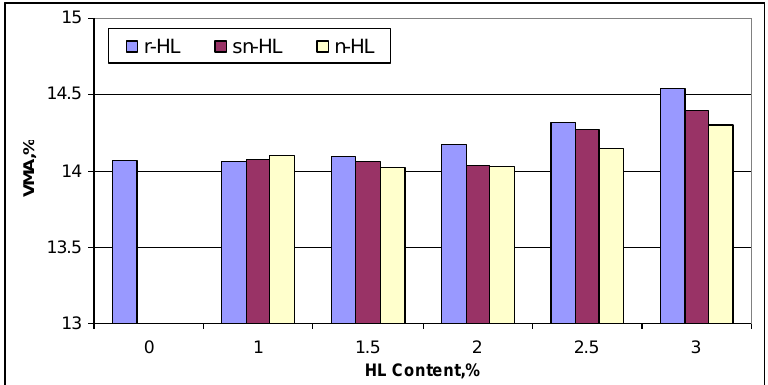
Figure 11. Comparison of VMA.